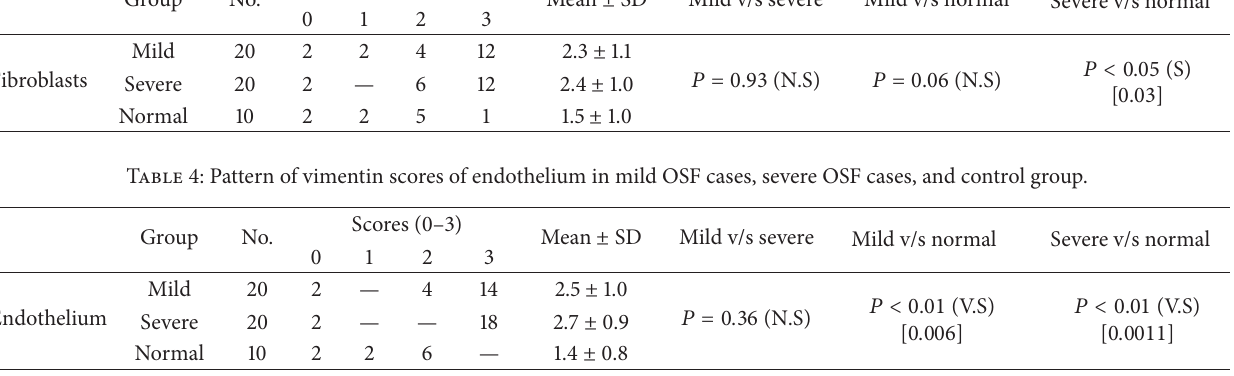
Deep Normal Table 3: Pattern of vimentin scores of fibroblasts in mild OSF cases, severe OSF cases, and control group. Group